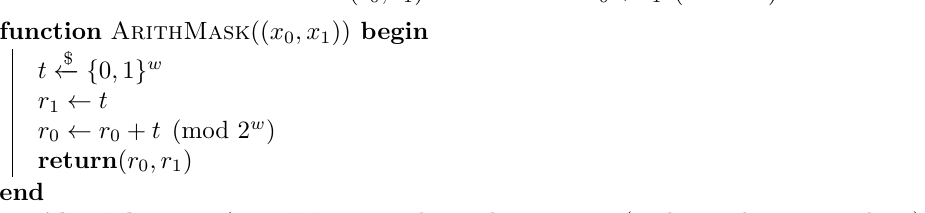
Algorithm 14: BoolROR : apply right-rotate operation (under Boolean masking). Data: The value x .